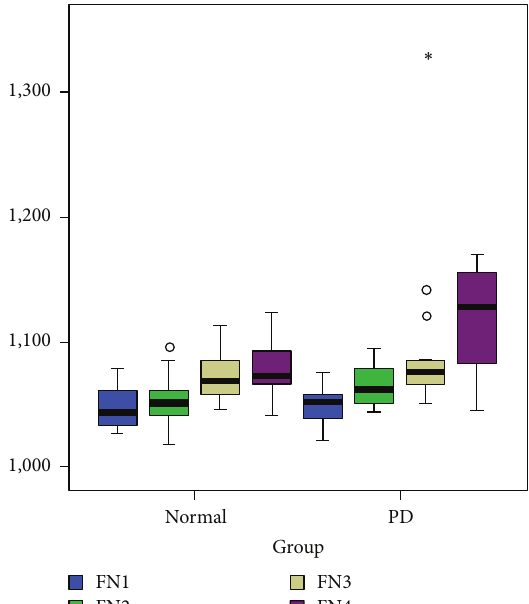
Figure 5: Descending pattern of increasing iron deposition along the FN (FN1 is rostral and FN4 is caudal and also contains the averages of slices more caudal to FN4 when present). ∗ = outlying value.